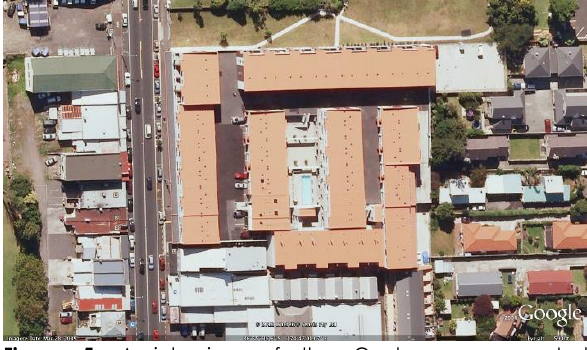
Figure 5. Aerial view of the Onehunga case study